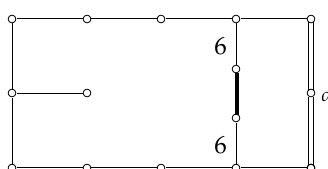
Figure 10. Mcleod’s Coxeter group Γ ⊂ Isom H 11